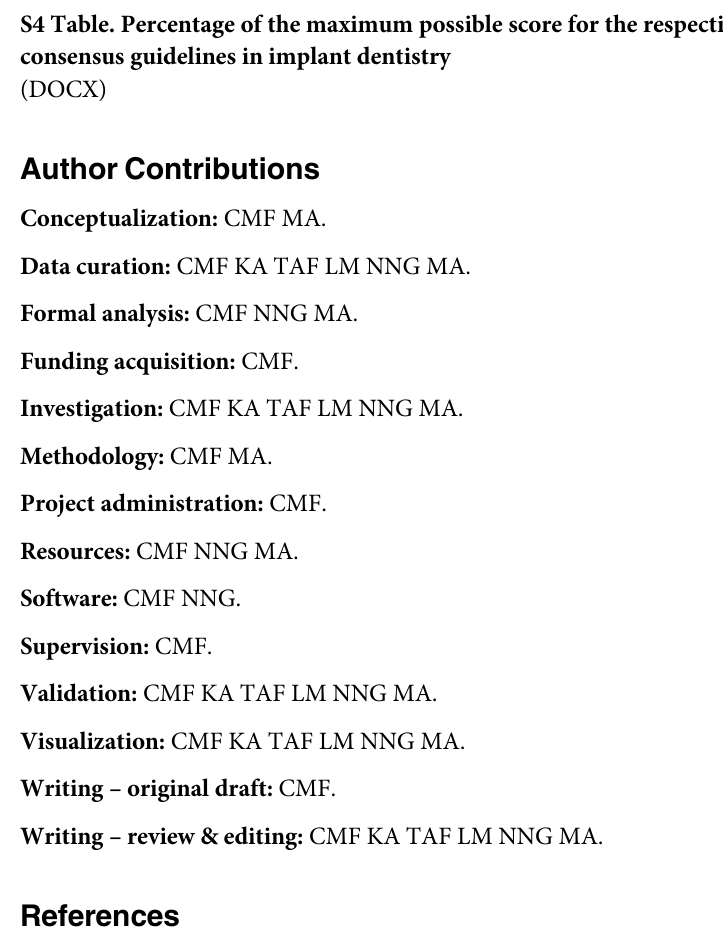
S4 Table. Percentage of the maximum possible score for the respective domains across consensus guidelines in implant